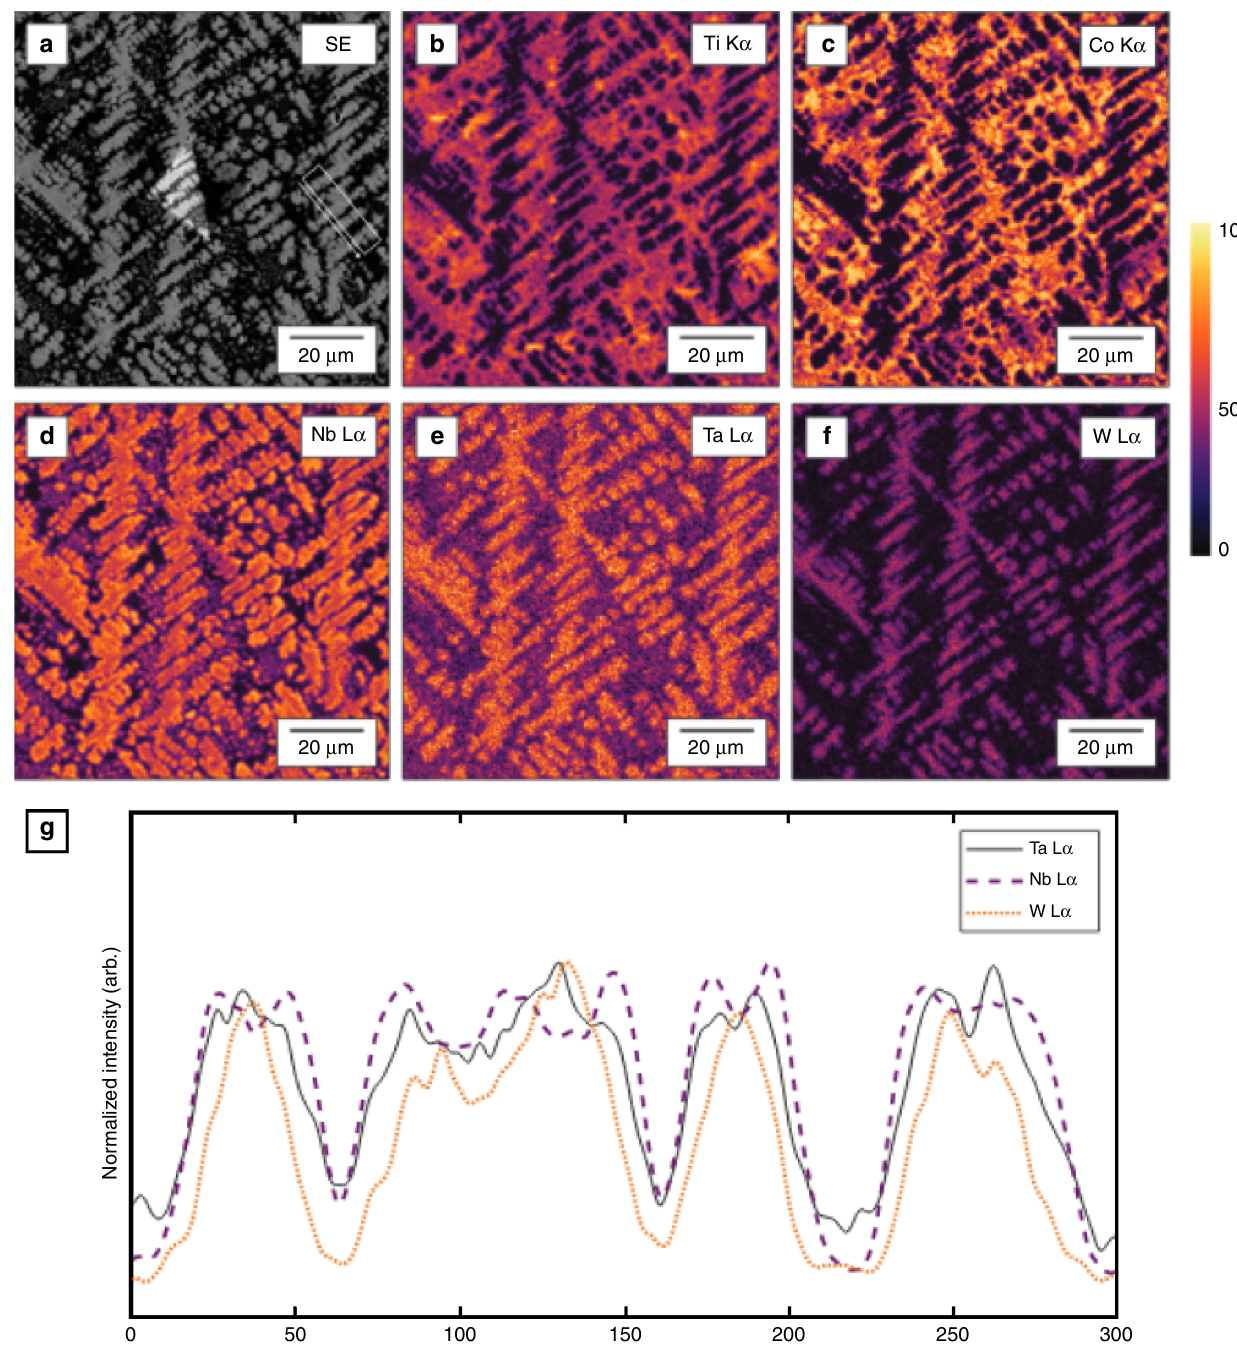
Fig. 8 Energy-dispersive spectroscopic (EDS) map of a soft alloy. An EDS map of the as-cast microstructure of Ti 39 W 04 Nb 31 Ta 04 Co 22 and evidence of coring. a Secondary electron image and X-ray intensity maps produced by integrating b Ti K α , c Co K α , d Nb L α , e Ta L α , and f W L α X-ray signals. The color scale represents the relative intensity based on the number of counts per pixel. The dendrites were found to be rich in Nb, Ta, and W, while the inter- dendritic phase is composed primarily of Co and Ti. Evidence of dendrite coring can be seen in g , a line pro fi le showing the normalized intensity of W L α , Ta L α , and Nb L α X-ray signals taken from the box in a with an arrow indicating the direction of the line pro fi le from left to